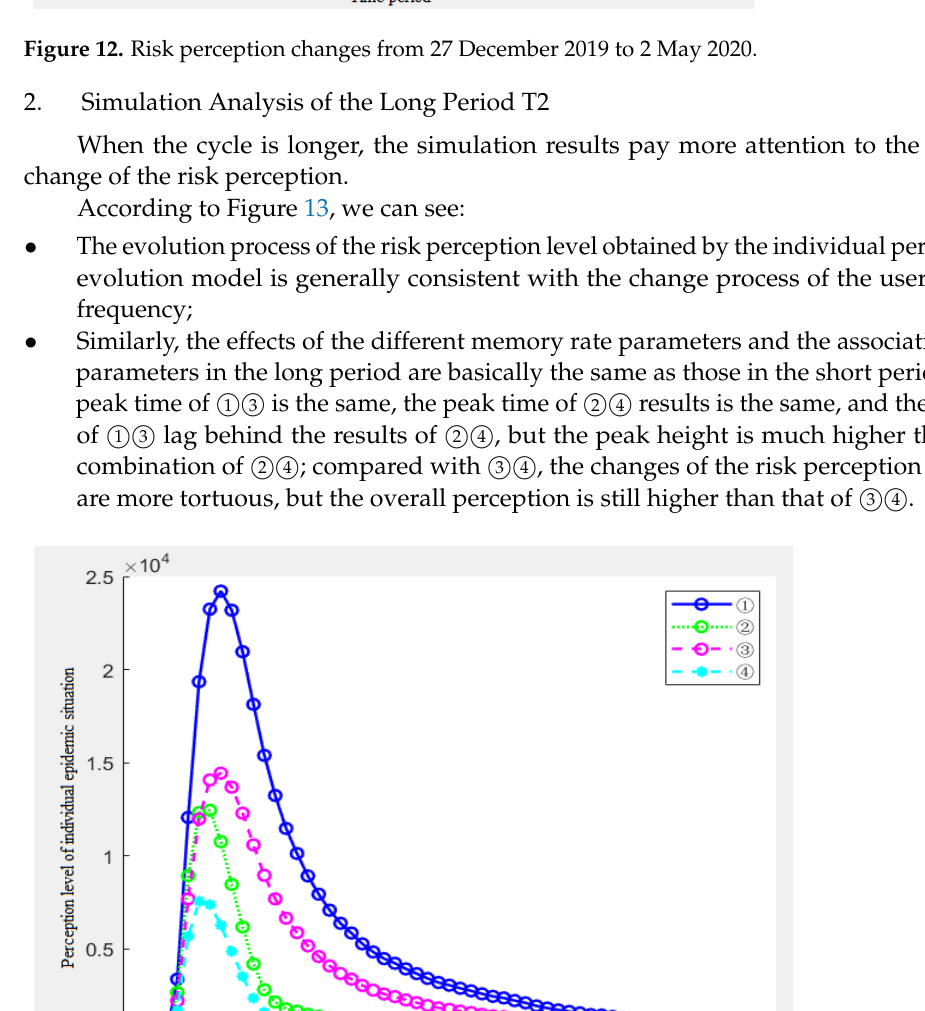
Figure 12. Risk perception changes from 27 December 2019 to 2 May 2020.